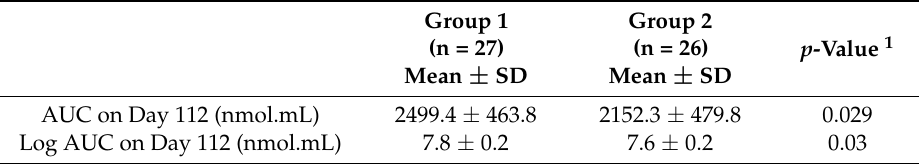
Table 2. Area Under the Curve (AUC) and log AUC at Day 112.